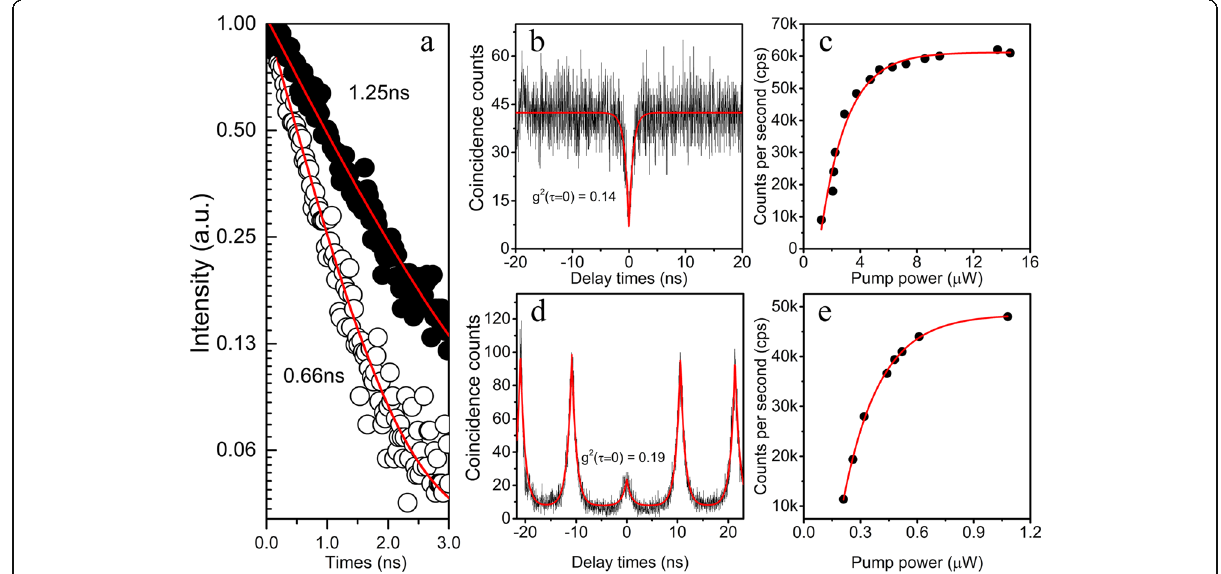
Fig. 4 a Time-resolved measurements on ( white circle ) and off (black circle ) resonant of the X line in micropillar, which reveal a Purcell factor of F p = 1.9. b , d Second-order correlation function g (2) ( τ ) for the X line under cw excitation and 80 MHz pulse laser excitation at saturated pump power. c , e Pump power-dependent PL intensity of exciton peak at 1325.6 nm under cw and pulse excitation, respectively. The black circles in c and e denote the count rate recorded at the InGaAs